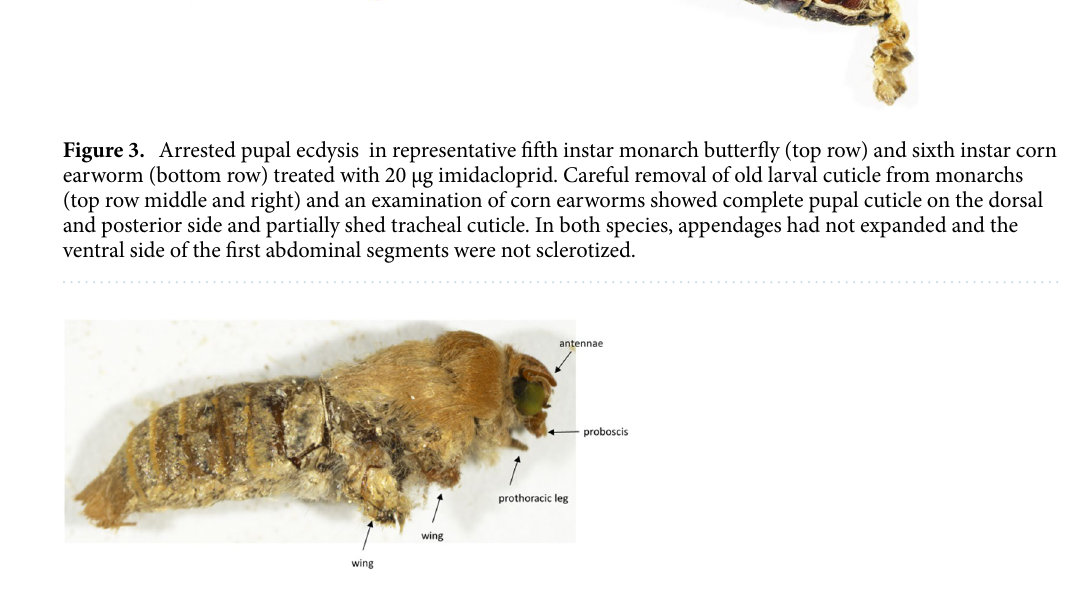
Figure 4. Corn earworm larvae that exhibited arrested pupal ecdysis were allowed to develop as adults. Careful removal of larval and pupal cuticle after adult development shows an adult with appendages (labeled) that did not